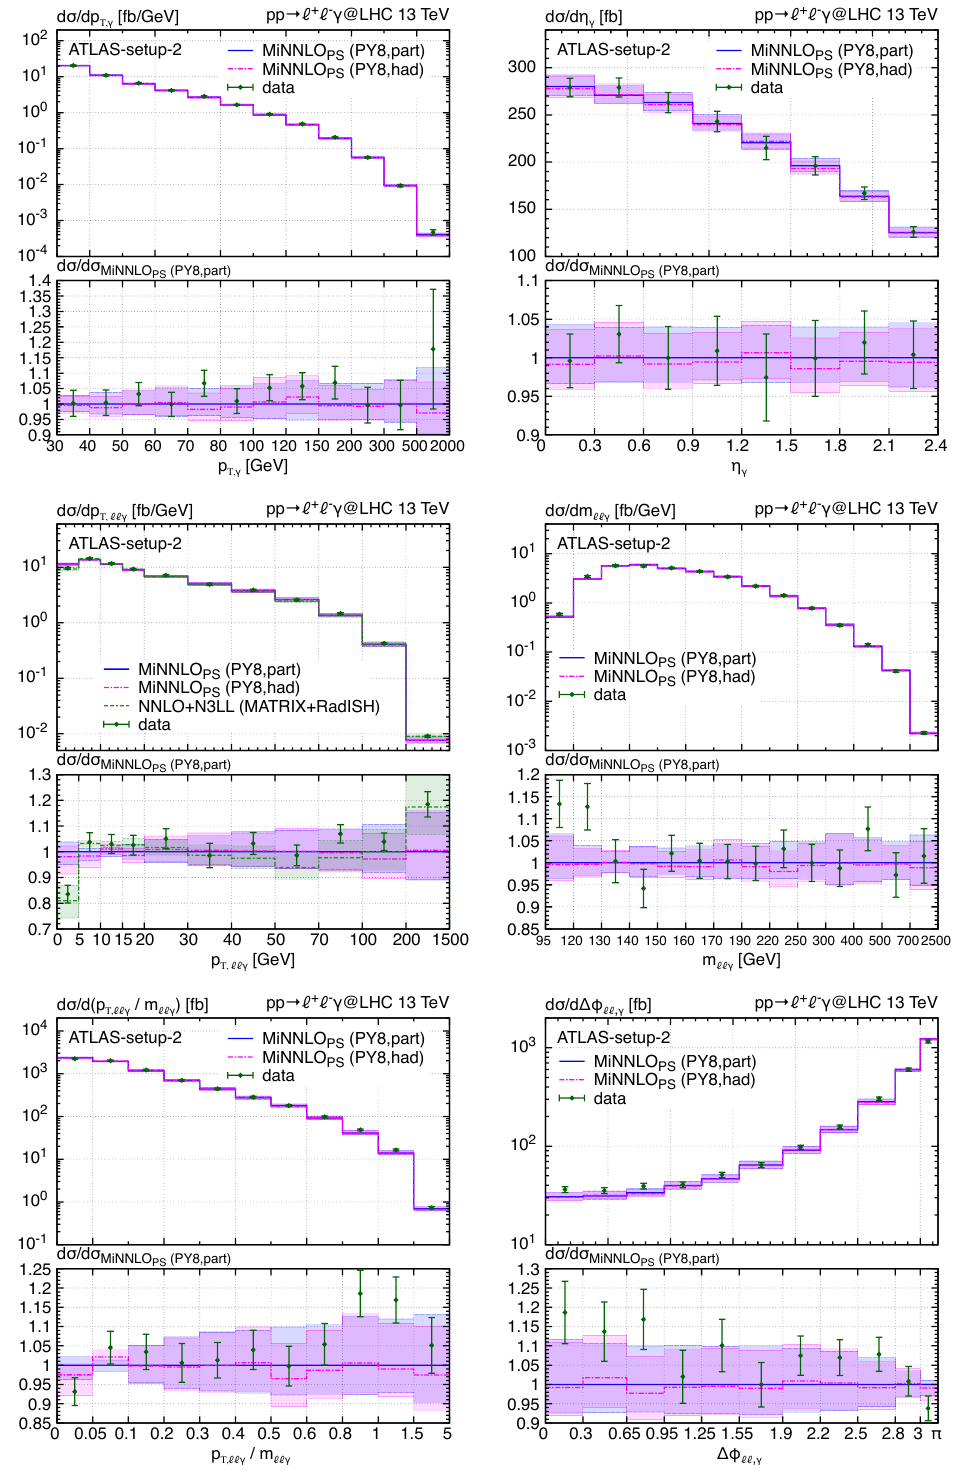
Figure 10. MiNNLO PS predictions at parton level (blue, solid line) and including hadronization (magenta, dash-dotted) compared to ATLAS 13 TeV data (green points with error bars). For p also NNLO+N 3 LL (green, double-dash-dotted line) is